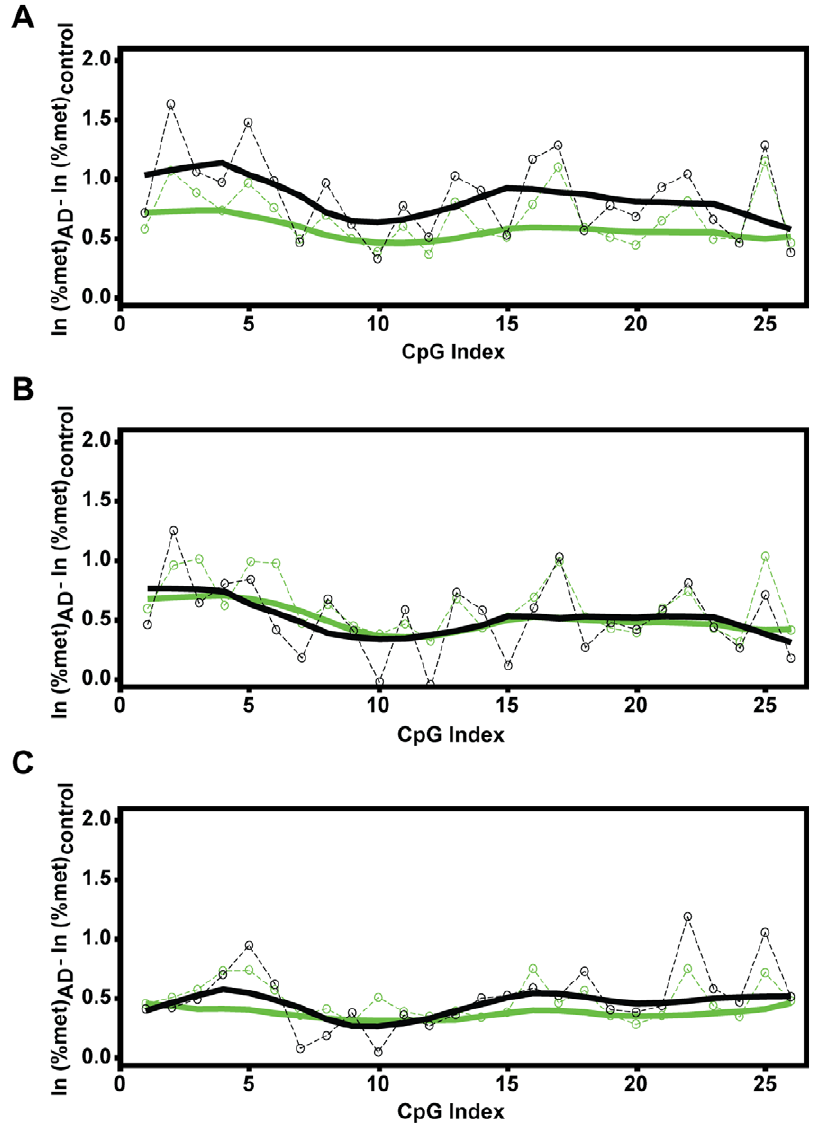
Figure 4. Local regression analysis of mC content across the rDNA promoter. After logarithmic transformation of the data from Fig. 3, the mean differences in methylation of each of 26 individual CpG sites in the rDNA promoter were determined as indicated. A , Local regression analysis of the mean difference between MCI- and control groups (parietal cortex) indicates significant hypermethylation of all CpGs of the rDNA promoter. The circles indicate the actual mean difference values; the black solid line represents a smoothed regression fit of those values across the rDNA promoter region; the green lines indicate the border of the 95% confidence range for the actual values (dashed line) or the smoothed regression (solid line). Note that the black smoothed regression line does not leave the 95% confidence range, indicating a significant hypermethylation trend for all the CpG sites. B–C , Similar analysis of the data for the AD samples from the parietal (B) and the prefrontal cortex (C) identifies AD-associated hypermethylation of large portions of the rDNA